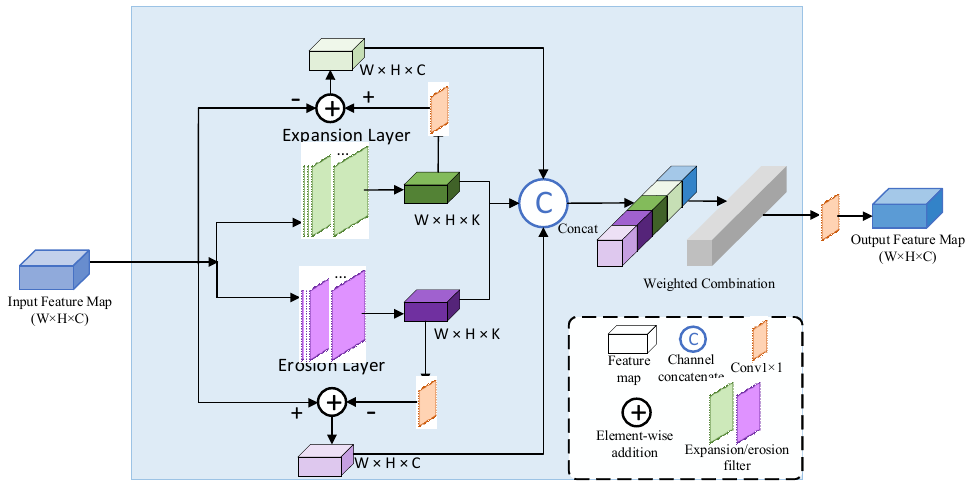
Figure 4. Example diagram of an erosion operation.